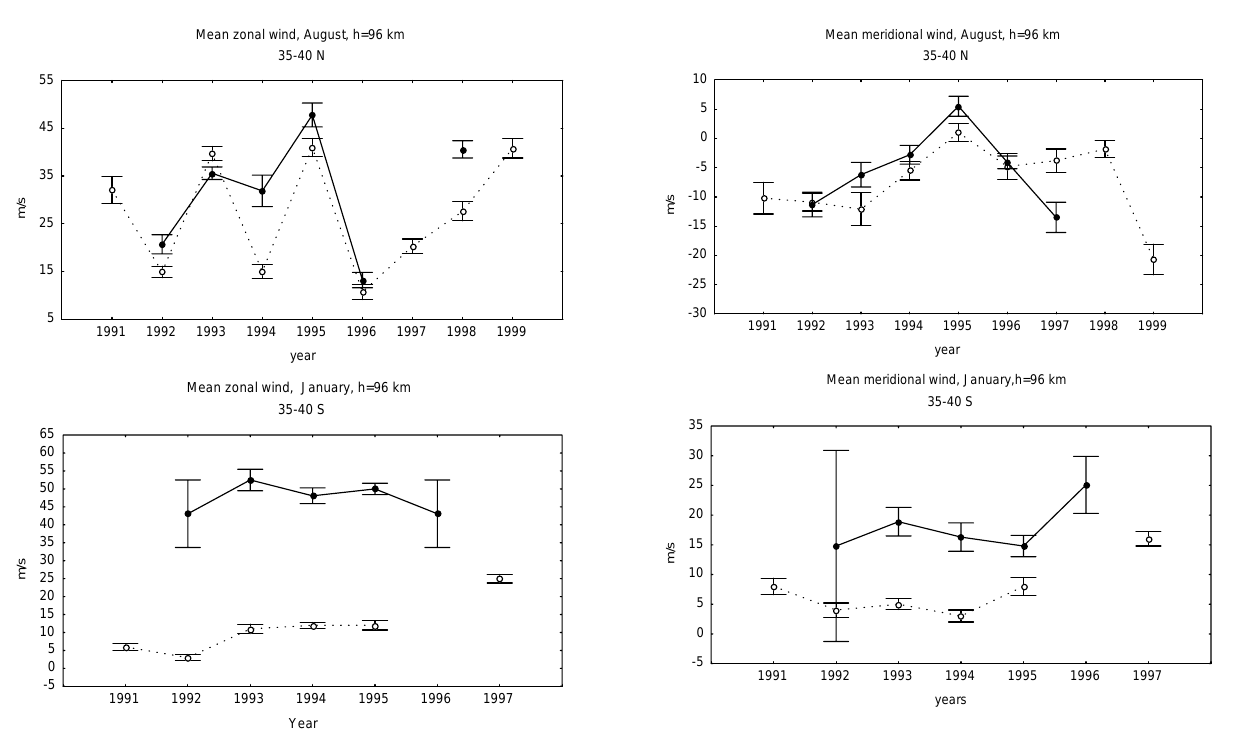
Fig. 13. Same as Fig. 12, except for the meridional wind compo-